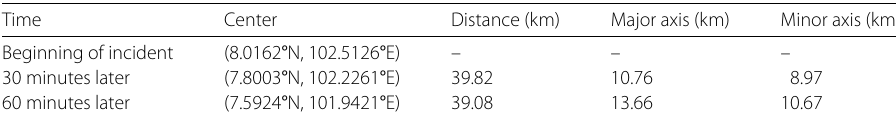
Table 2 The size in ellipse and position of oil slick starting at South Bongkot 23 oil drilling rig at different times.